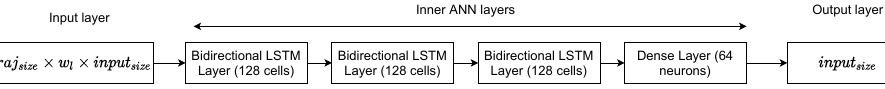
Figure 6. Approach of the ANN architecture.